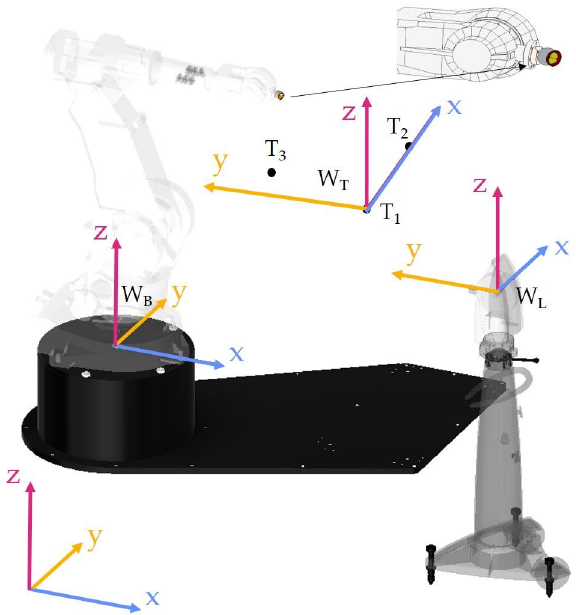
Figure 7. The idea of determining the Base Frame.